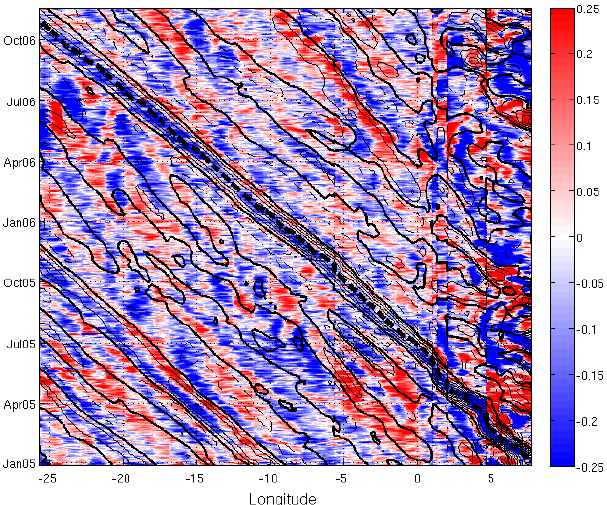
Figure 1. Time series of the maximum (warm) and minimum (cold) T 0 inside the eddy (thin lines) and absolute SST at the eddy center (thick Time series of the maximum (warm) and minimum (cold) T' inside the eddy (thin lines) and absolute line) for an Agulhas ring tracked between January 2005 and February 2007. SST at the eddy center (thick line) for an Agulhas ring tracked between January 2005 and February 2007.